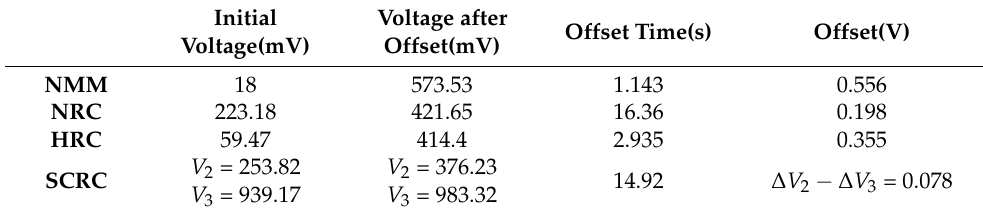
Figure 9. ( a ) Output waveform diagram of NMM after reading logic “1”; ( b ) output waveform diagram of NRC after reading logic “1”; ( c ) output waveform diagram of HRC after reading logic “1”; and ( d ) voltage waveform diagram at V 2 of SCRC after reading logic “1”. Table 2. Results of continuous reading of logic “1”.